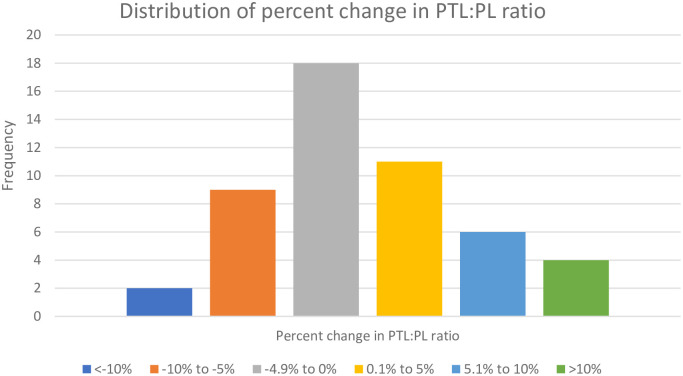
Distribution of percent change in PTL:PL ratios.The percent change was calculated using pre-operative PTL:PL measurements compared to final follow-up measurements.